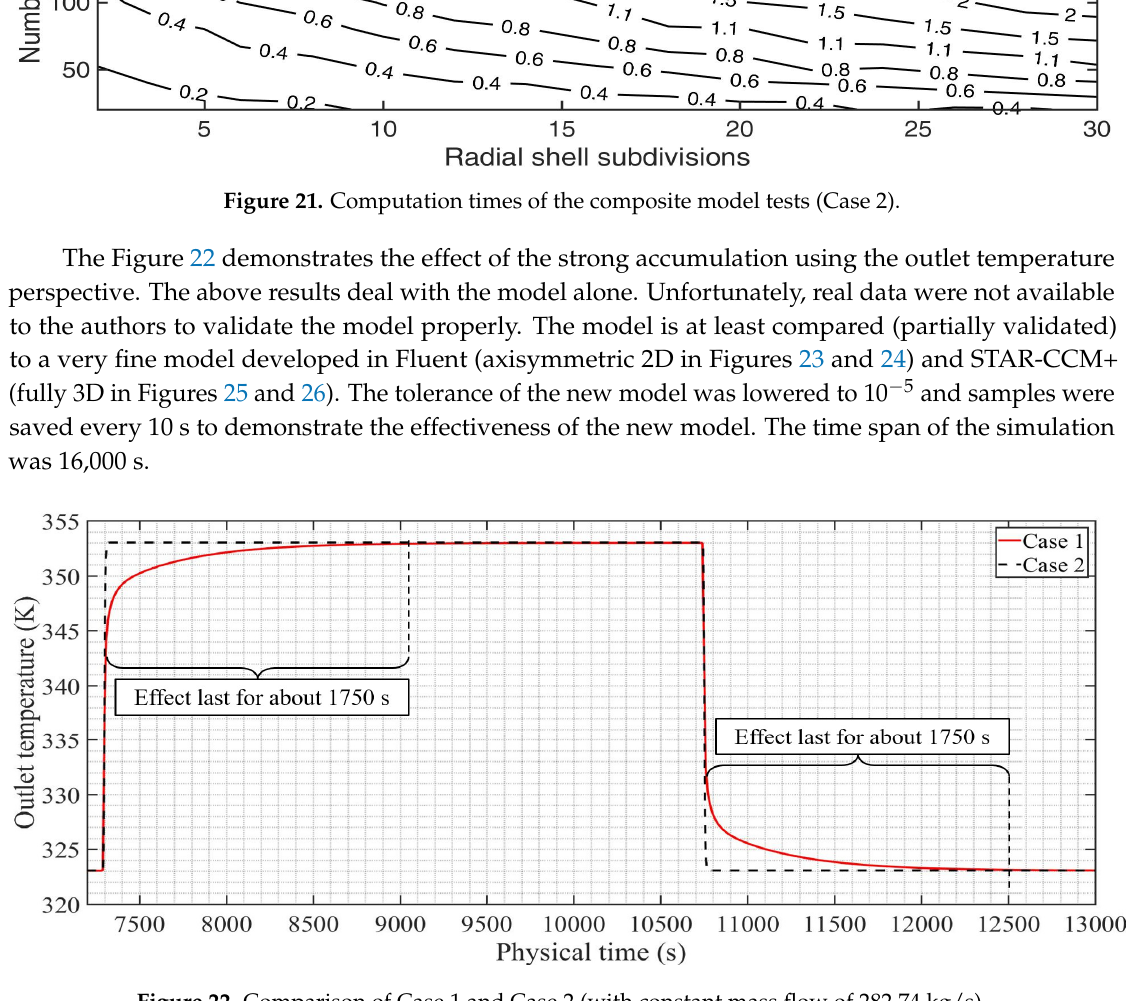
Figure 21. Computation times of the composite model tests (Case 2).